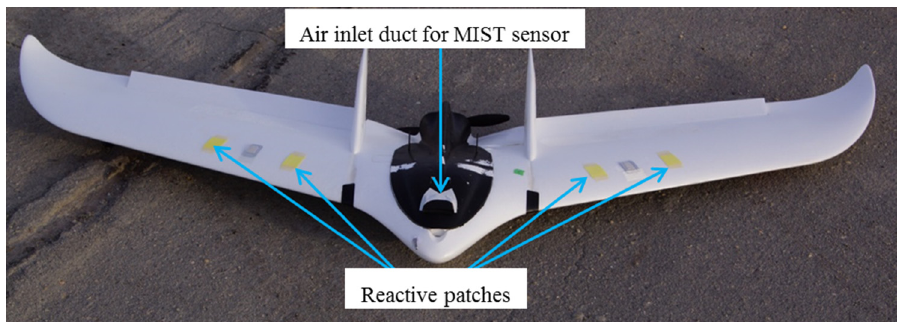
Figure 3. Phantom Fx61 UAS ready for NEFT/EFT with payload sensor and reactive patches applied.